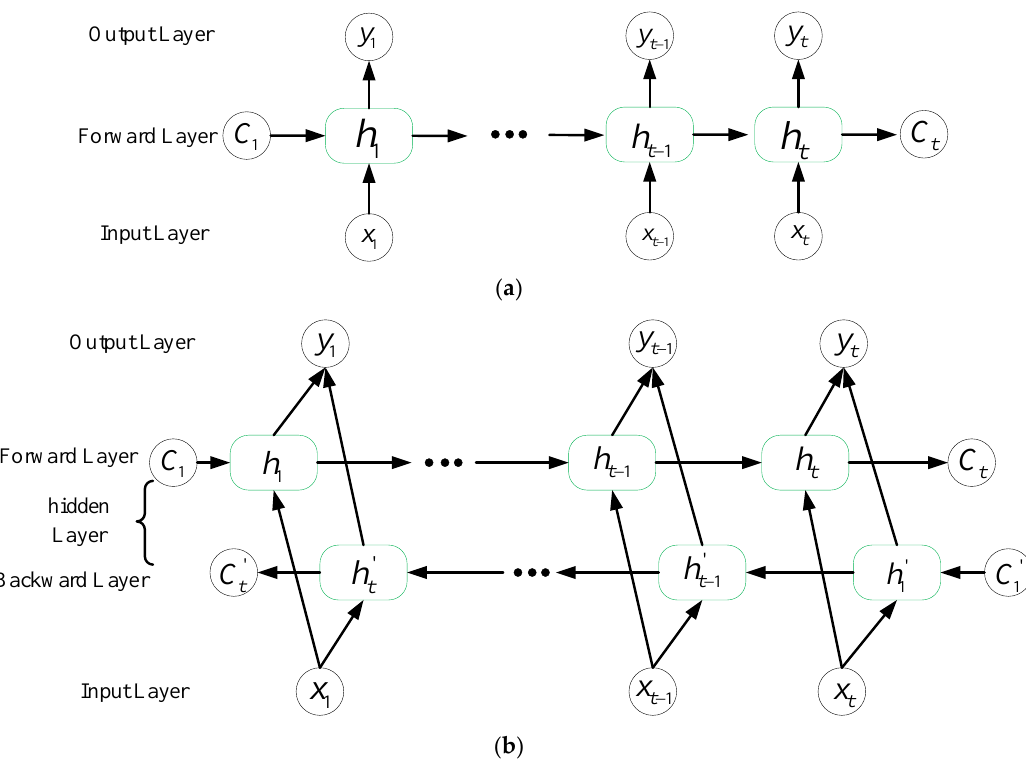
Figure 4. Illustration of a LSTM model ( a ) and a bidirectional (Bi-LSTM) model ( b ).